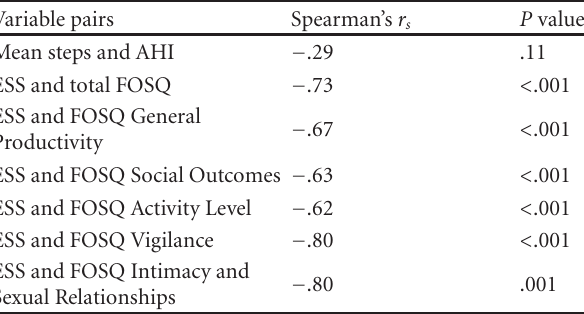
Table 2: Correlations among study variables.